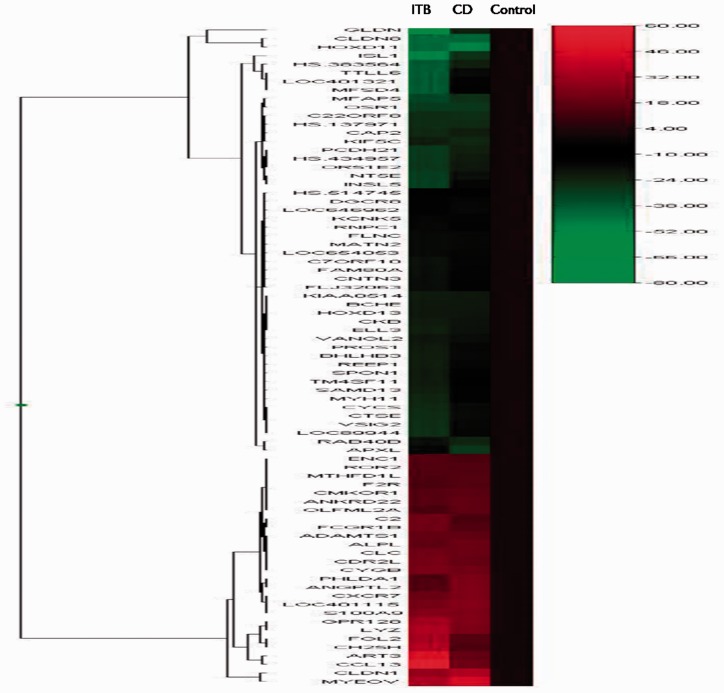
A heat map showing hierarchical clustering genes specifically regulated in patients with intestinal tuberculosis as compared with those with Crohn’s disease.